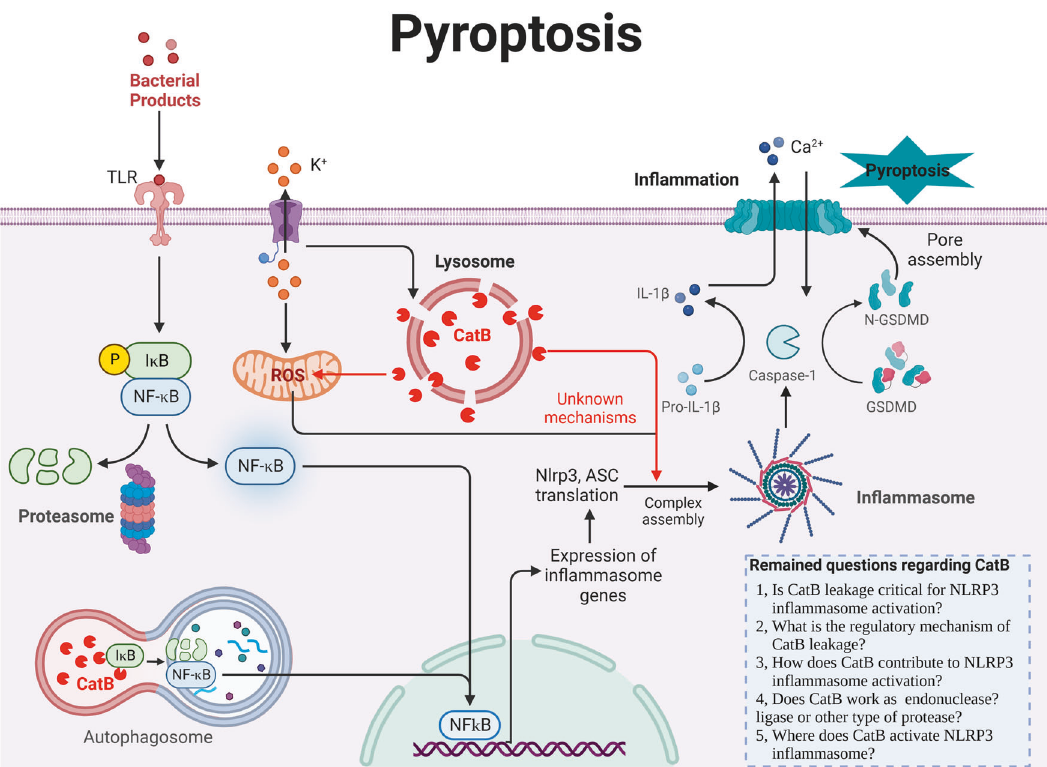
Fig. 3 Schematic representation of CatB and its substrates in the core pyroptosis machinery. Activation of NLRP3 in fl ammasome in macrophages requires two steps: priming and activation. The priming step is provided by in fl ammatory stimuli such as TLR agonists, which induce NF- κ B-mediated NLRP3 and pro-IL-1 β expression. The activation step is triggered by PAMPs and DAMPs. Upon stimulation, NLRP3 oligomerizes and recruits ASC through homotypic PYD-PYD interactions and leads to helical ASC fi lament formation. Assembled ASC recruits caspase 1 and enables proximity-induced caspase 1 self-cleavage and activation, which in turn cleaves pro-IL-1 β and GSDMD. GSDMD inserts into the membrane, forming pores and inducing pyroptosis. It has been demonstrated that CatB is a critical factor for NLRP3 in fl ammasome activation but the precise molecular mechanisms and cellular space are unclear. The remained questions regarding CatB are listed at the right- bottom of the fi gure. CatB cathepsin B, DAMPs damage-associated molecular patterns, GSDMD gasdermin, IL interleukin, I κ B I kappa B kinase, NF- κ B nuclear factor kappa-light-chain-enhancer of activated B cells, NLRP3 NACHT-, leucine-rich-repeat- (LRR), and pyrin domain (PYD)- containing protein 3, PAMPS pathogen-associated molecular patterns, ROS reactive oxygen species, TLR toll-like forms of stress-induced lysosomal membrane permeabilization resulted in lysosomal-dependent cell death. Using pharmacologi- cal inhibitors and genetic models of ferroptosis, lysosomal membrane permeabilization and cytoplasmic leakage of CatB were demonstrated to unleash structural and functional changes in mitochondria and promote cleavage of histone H3 in the nucleus [31]. On the other hand, CatB is demonstrated to involve in the predominantly degradation of albumin in lysosome. Cysteine is a proteogenic amino acid but also needed for the synthesis of glutathione (GSH), which is needed to prevent ferroptosis [32], because GSH is a co-substrate for glutathione peroxidase 4 that could reduce potentially toxic membrane lipid hydroperoxides to non-toxic lipid alcohols. CatB-dependent albumin breakdown followed by export of cystine from the lysosome via the transporter cystinosin fuels the synthesis of GSH [33]. However, catabolism of albumin in lysosome can supply the cell with cysteine need to synthesize GSH while possibly other protective sulfur containing metabolites, block lipid peroxidation, and prevent the onset of ferroptosis.